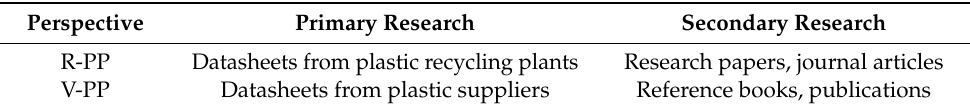
Table 1. Data collection matrix (see File S1); databases accessed March–July 2021.